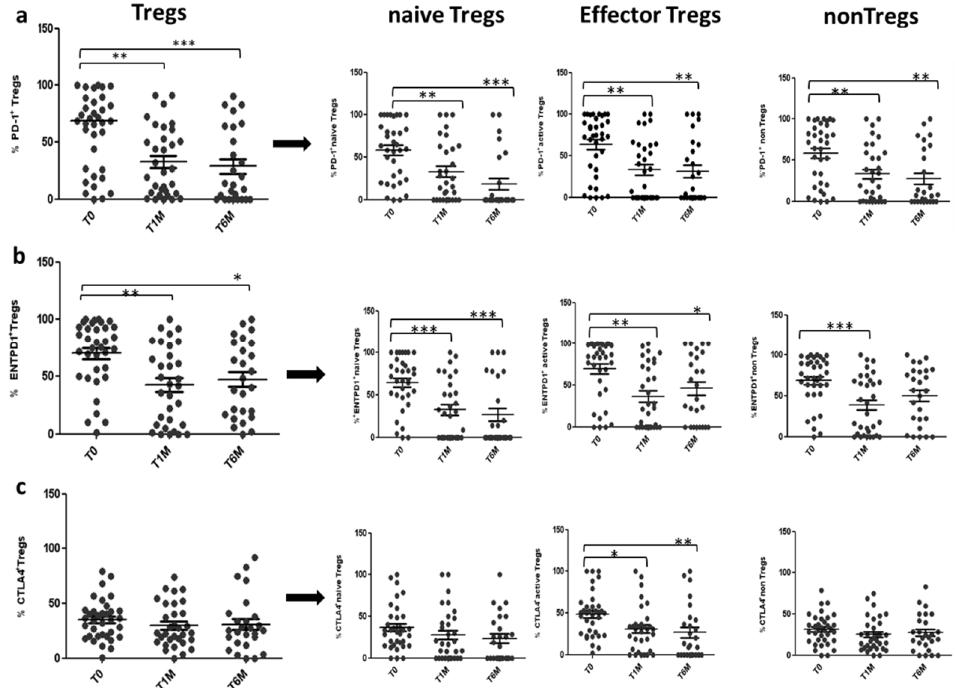
Figure 5. PD-1, ENTPD1, CTLA4 expression on Tregs during OCT LAR treatment: Expression of PD-1 ( a ), ENTPD1 ( b ) and CTLA4 ( c ) in Tregs and Tregs subpopulation, before (T0), after 1 month (T1M) and after 6 months (T6M) of OCT LAR treatment. * p < 0.05; ** p < 0.005; *** p < 0.0005.